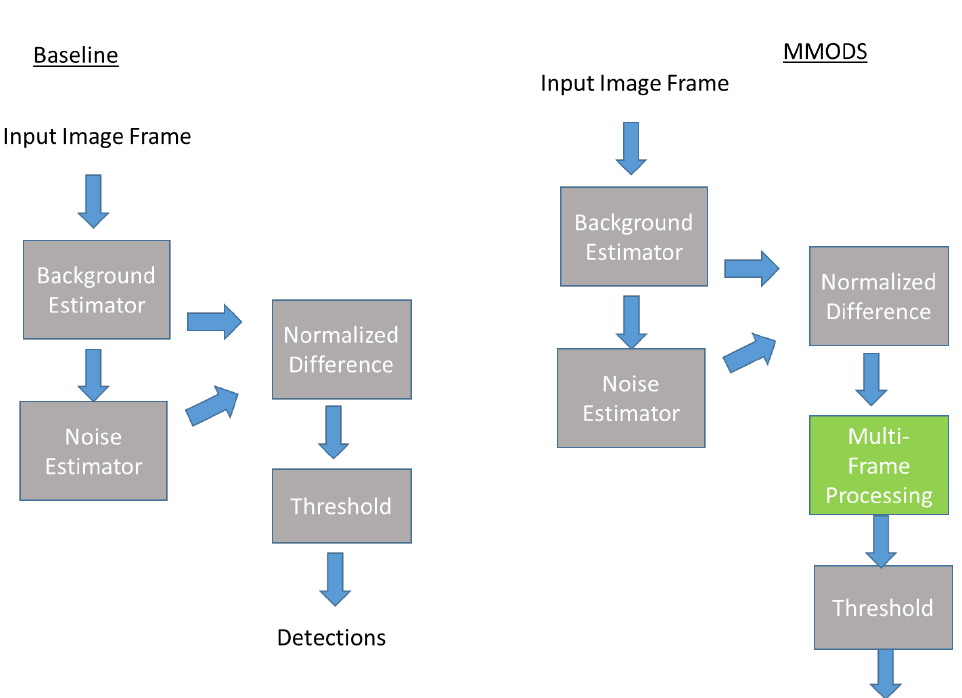
Figure 8. Evaluation Framework: Baseline Architecture vs. MMODS architecture.